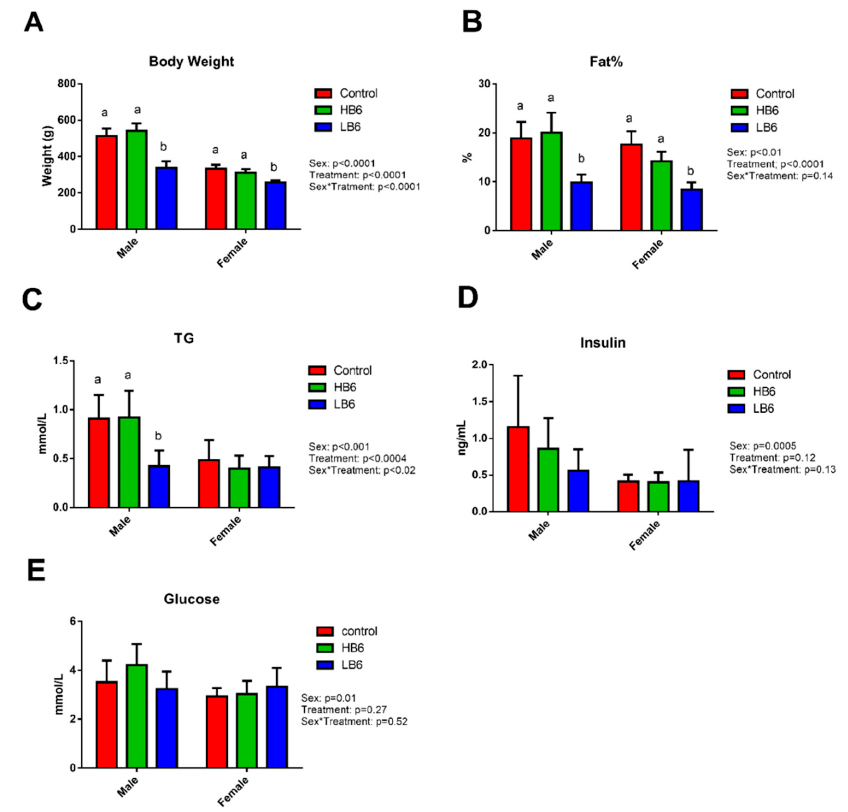
Figure 1. Primary physical and clinical markers showing effects of low and high dietary vitamin B6 levels on body weight ( A ), percentage fat ( B ), triglycerides ( C ), insulin ( D ), and glucose ( E ) in rats. Data represent mean ± SD ( n = 7–8/group of each sex). Values with different superscripts indicate significant differences between the treatment groups within the same sex ( p < 0.05).